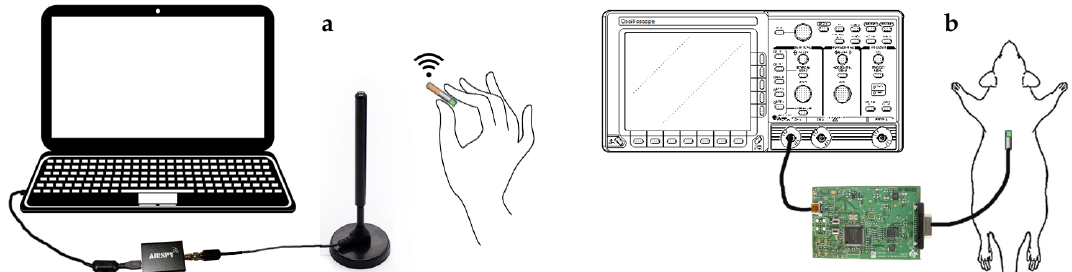
Figure 11. Visual description of the two experimental setups. ( a ) Wireless transmission was tested with the handheld capsule transmitting PPG data to the laptop through the dipole antenna and the Airspy R2 receiver. ( b ) In vivo performance was tested on an anesthetized rat with the optical probe injected in the thoracic area. The probe was connected to the ASIC test board and the AFE4490 evaluation board alternatively and the data was displayed on an oscilloscope.